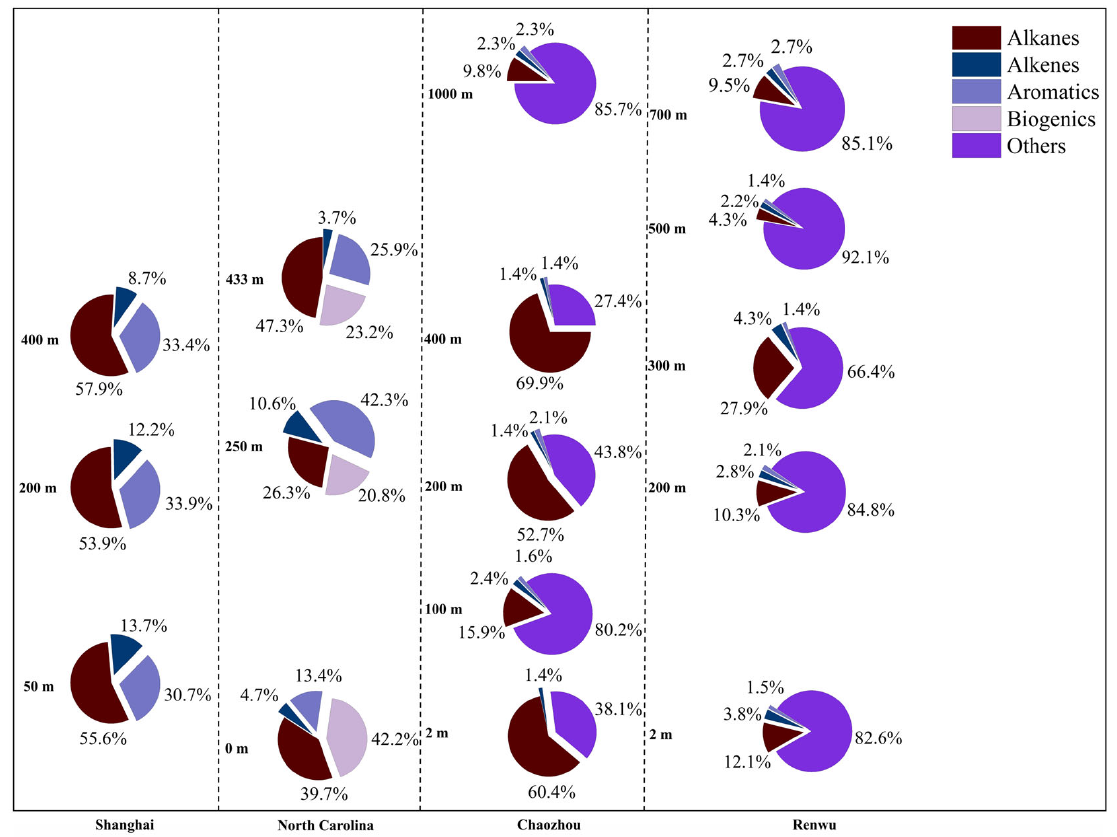
Figure 3. The contribution of each category of VOCs to TVOC concentrations in rural areas (Shanghai [100] and North Carolina [101]) and urban areas (Chaozhou and Renwu [89]).